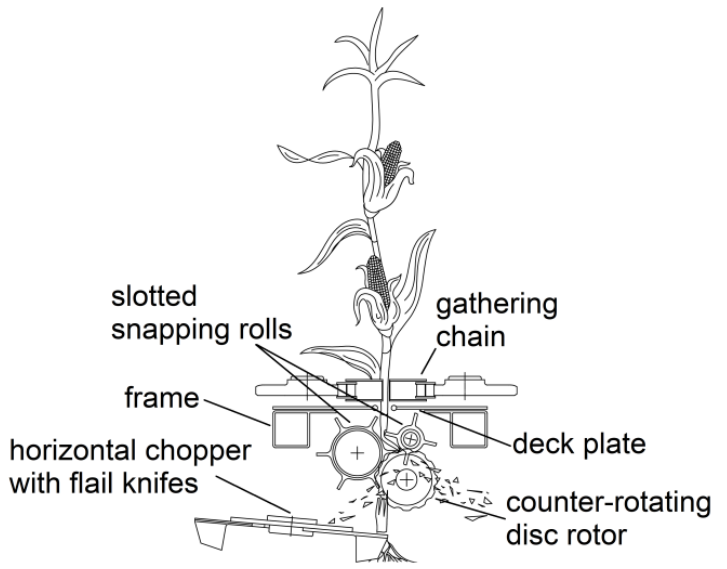
Figure 2. Structural diagram of the Horizon Star* III row unit (Adapted with permission from Carl Geringhoff GmbH & Co. KG, 2023).